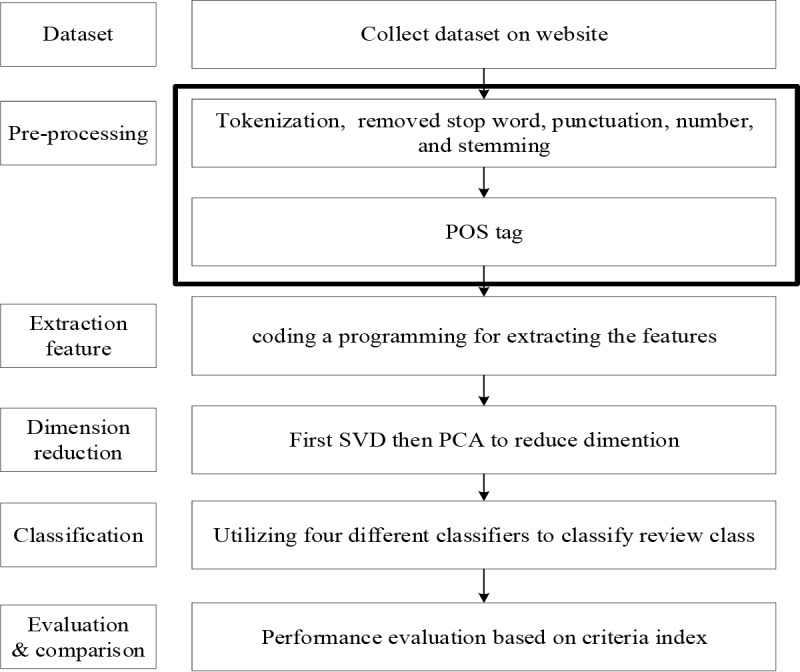
The proposed method.